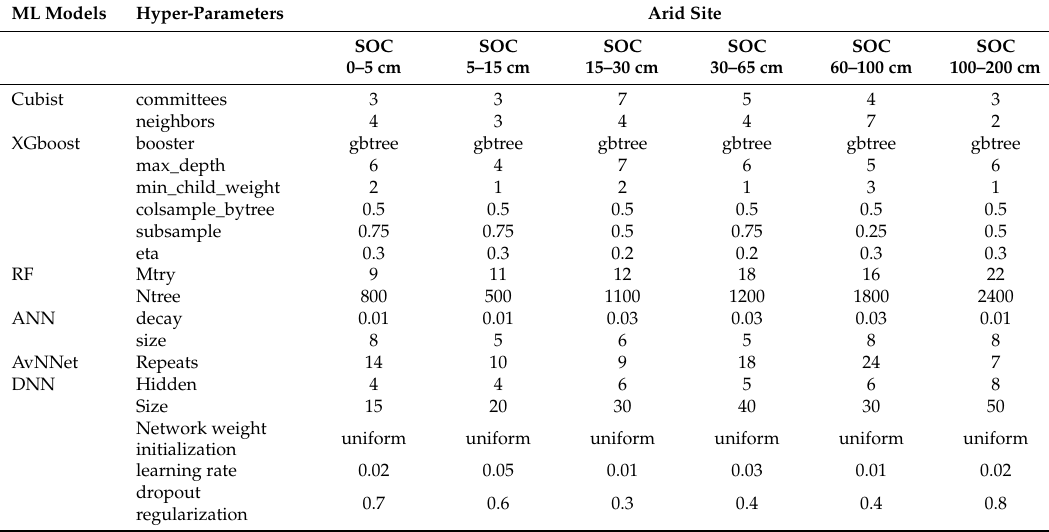
Table A1. The optimal set of hyper-parameters used for ML algorithms for prediction of SOC in the arid site.